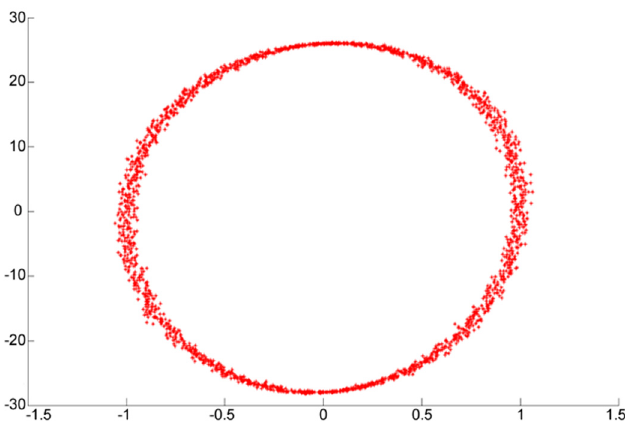
Figure 13. Chaotic trajectory for normal power system signal with 5% noise.